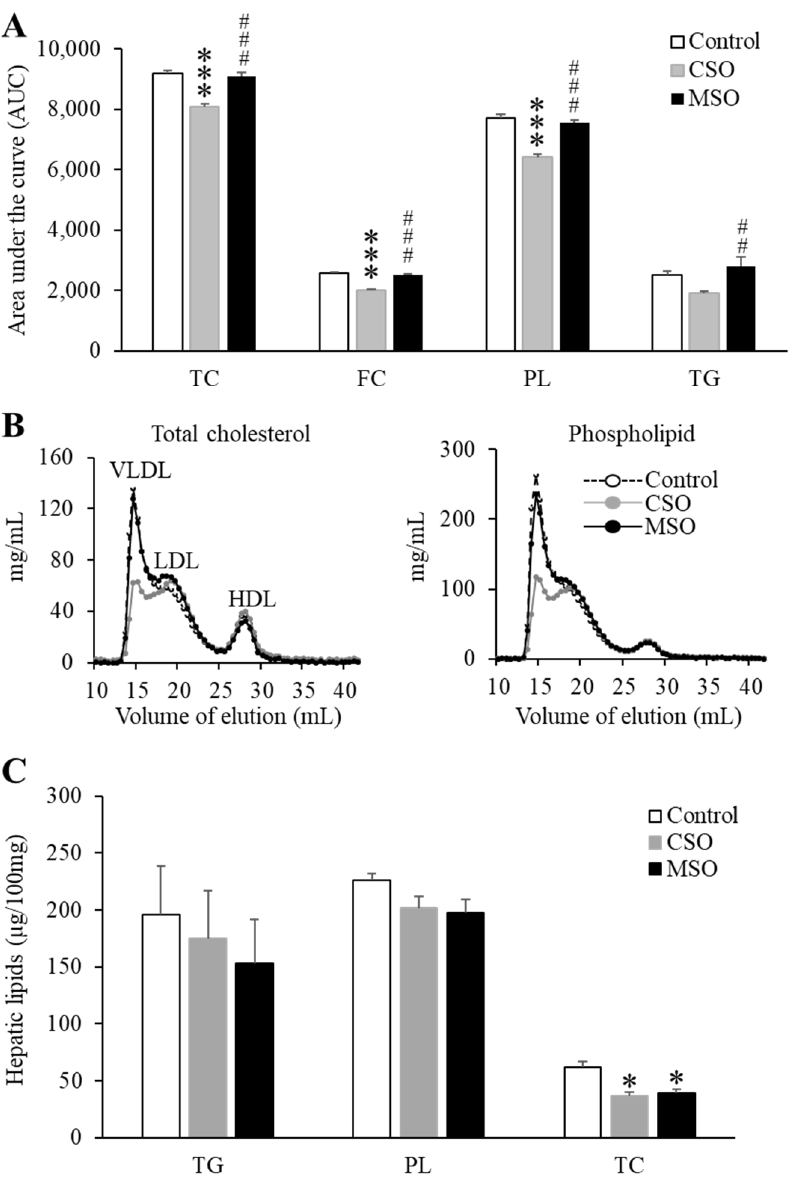
Figure 2. Effects of dietary CSO and MSO on plasma and hepatic lipid profiles in LDLR-KO mice. Mice (n = 12/group) were fed a Western diet supplemented with 5% ( w / w ) CSO, MSO, or none (control) for 12 weeks. ( A ) Area under the curve (AUC) for plasma triglyceride, phospholipid, total cholesterol, and free cholesterol from baseline through 12-week period. ( B ) Distribution of pooled plasma total cholesterol and phospholipid in VLDL, LDL and HDL fractions separated by FPLC. ( C ) Hepatic triglyceride, phospholipid, and total cholesterol levels. CSO: conventional soybean oil, MSO: modified soybean oil. TC: total cholesterol, FC: free cholesterol, PL: phospholipid, TG: triglyceride. Values represent the mean ± SEM. * p < 0.05, *** p < 0.001 compared with the control Western diet; ## p < 0.05, ### p < 0.001 compared with the CSO diet.